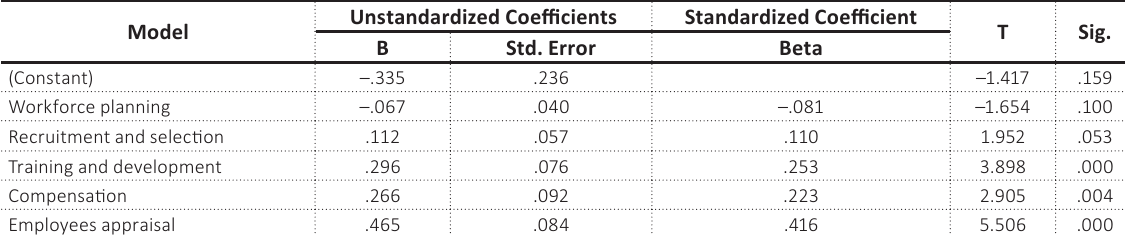
Table 4. Regression coefficients for H1